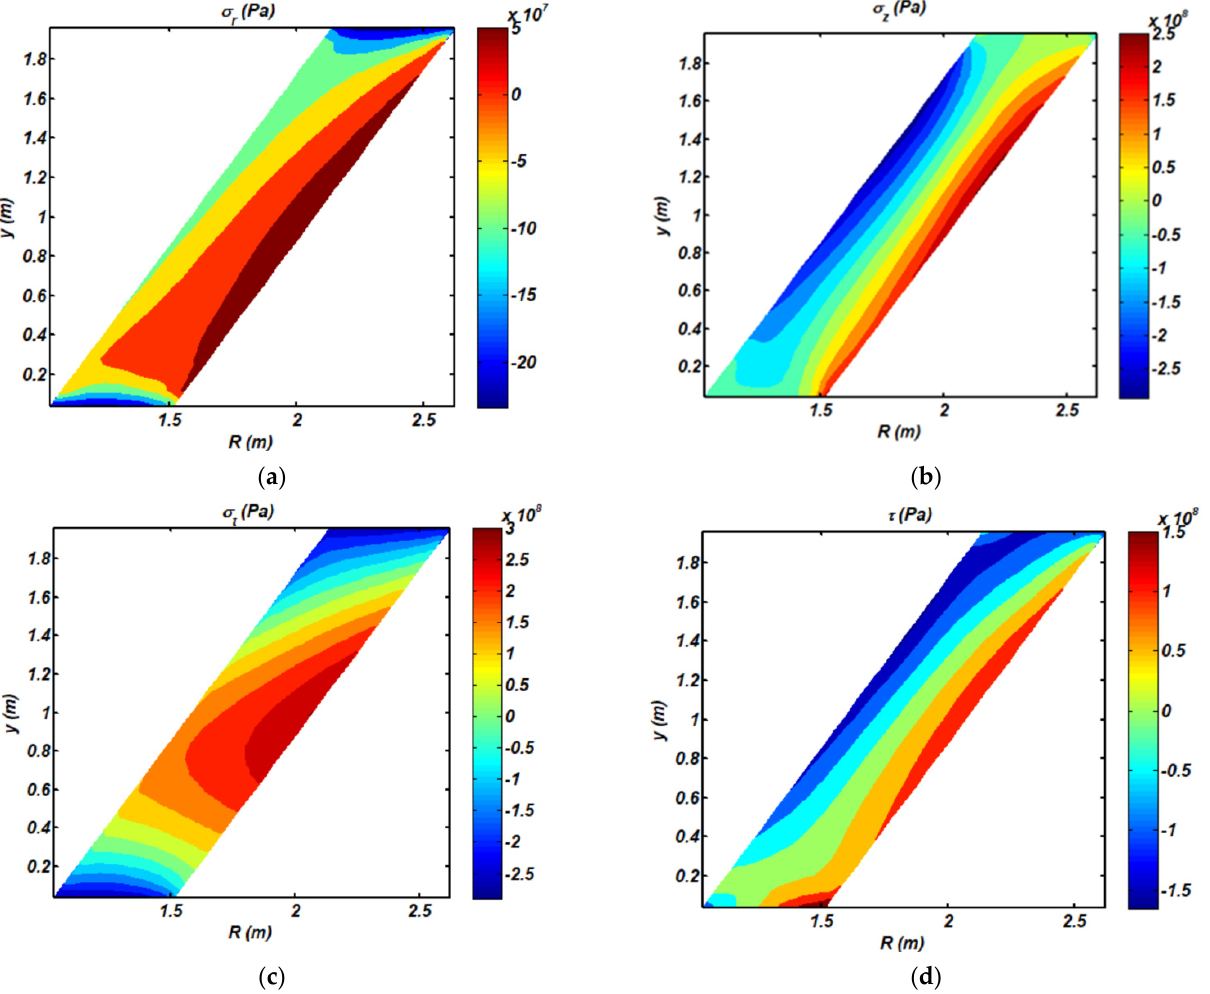
γ ω φ = 30°; GPL = 0.01; = 100